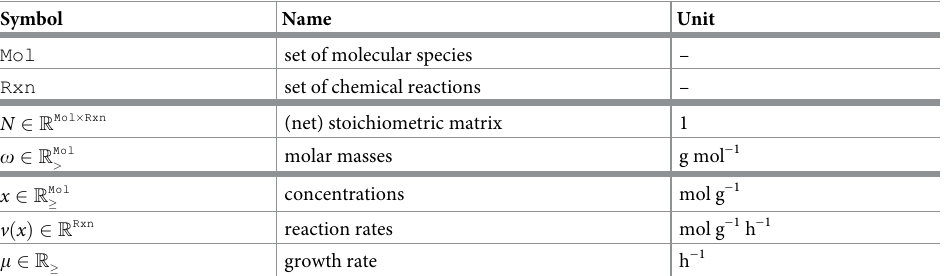
Table 1. Fundamental objects and quantities of cellular